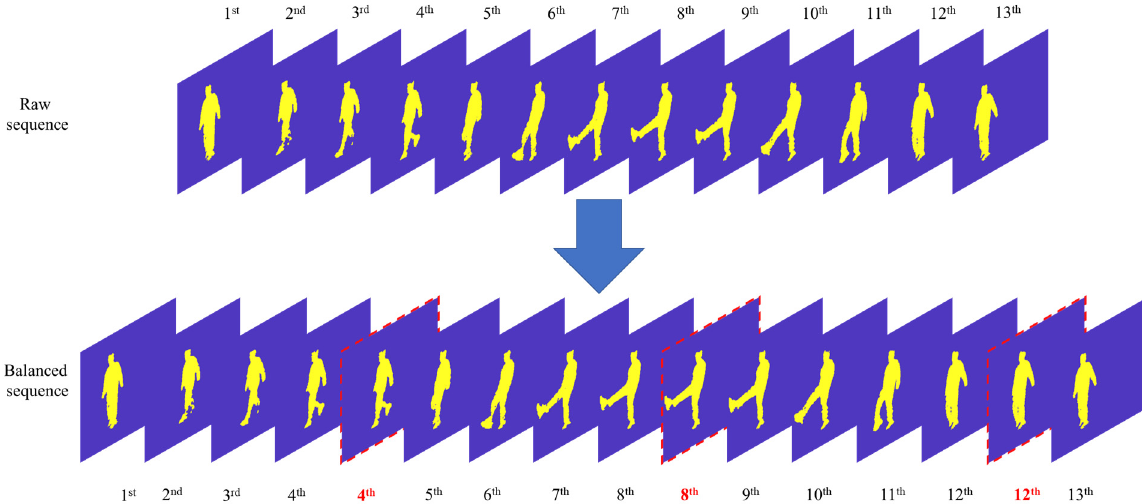
Figure 4. The procedure of balancing a sequence into 16 frames from 13 frames.